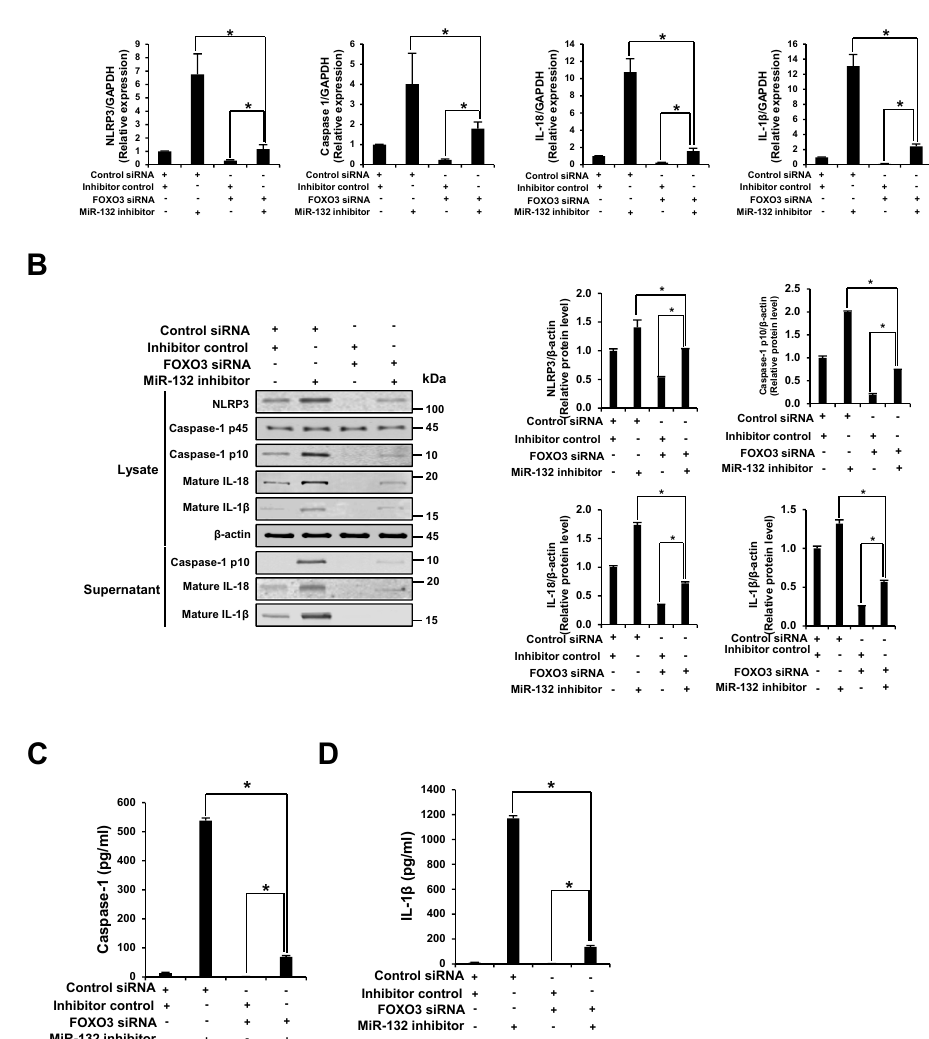
Figure 7. NLRP3 inflammasome activation through miR-132 inhibitor is attenuated by the knockdown of FOXO3. THP-1 cells were co-transfected with 20 nM inhibitor negative control or miR-132 inhibitor plus 20 nM control or FOXO3 siRNA for 48 h. ( A ) The mRNA levels of NLRP3, caspase-1, IL-18, and IL-1 β were examined by quantitative RT-PCR; ( B ) Cell lysates and supernatants were subjected to Western blot analysis using antibodies specific for NLRP3, caspase-1, IL-18, IL-1 β , and β -actin. β -Actin was used as a loading control; ( C , D ) The levels of caspase-1 and IL-1 β in the culture supernatants were determined by ELISA. All results are representative of three independent experiments. * p < 0.05 between the two